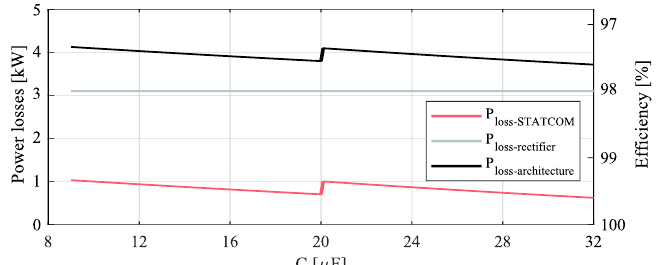
Figure 15. The 2L st architecture efficiency depending on the input filter capacitance (operating at V ph = 115V and f =360 Hz).